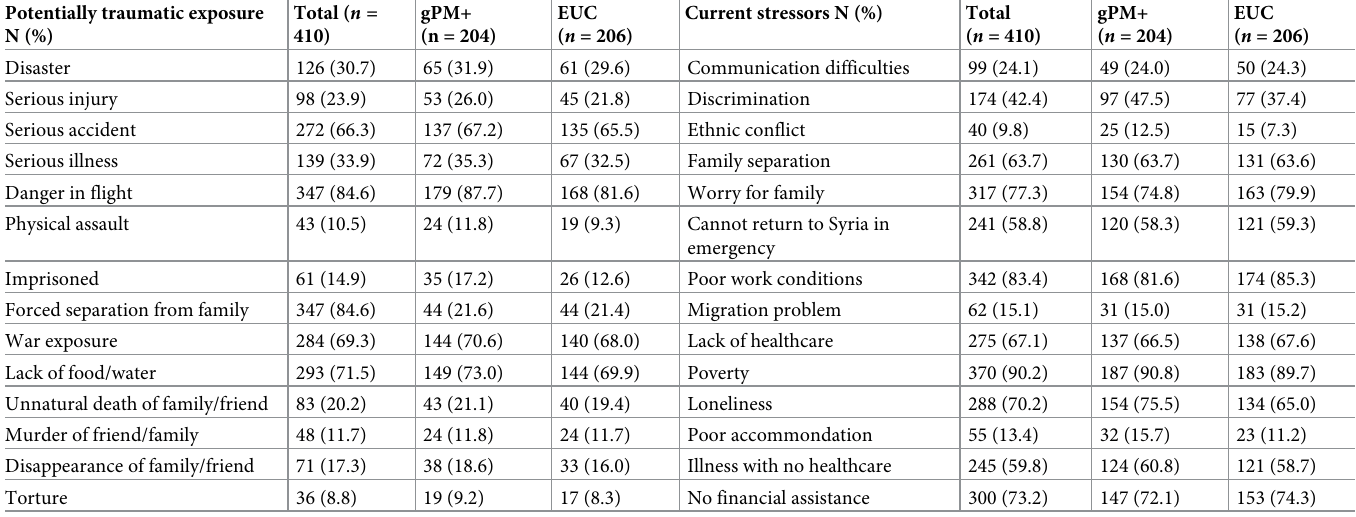
Table 2. Frequencies and percentages of rates of potentially traumatic exposures and current